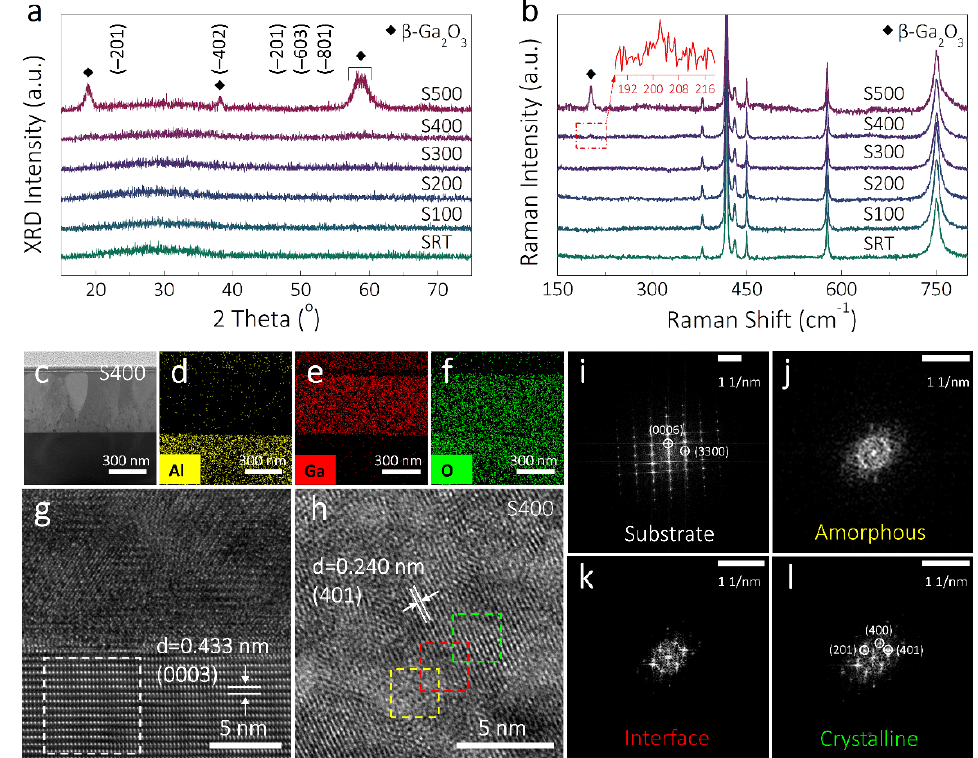
Figure 1. XRD pattern ( a ) and Raman scattering spectra ( b ) of Ga 2 O 3 films annealed with different temperatures. ( c ) The SEM image of the cross-section of mixed-phase Ga 2 O 3 (S400) and the corresponding EDX elemental mapping images of Al ( d ), Ga ( e ), and O ( f ). ( g ) Cross-sectional TEM image of Ga 2 O 3 /c-Al 2 O 3 interface (S400). ( h ) Magnified HRTEM image of mixed-phase Ga 2 O 3 film, the yellow, red, and green dotted selected areas correspond to the amorphous, interface, and crystalline regions, respectively. FFT pattern of substrate ( i ), amorphous region ( j ), amorphous/crystalline interface ( k ), and crystalline region ( l ).